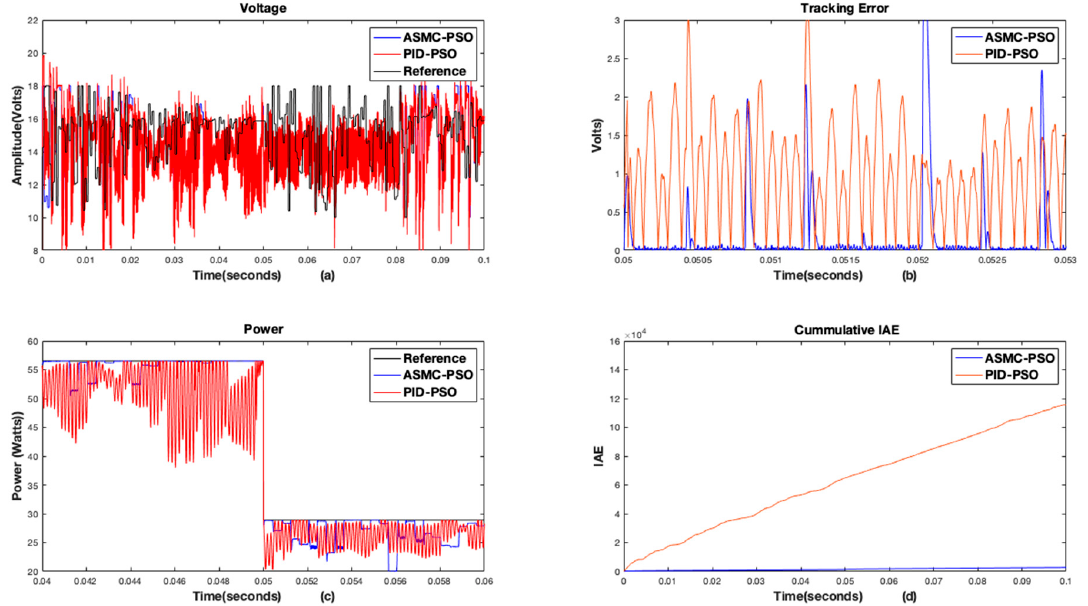
Figure 9. PID & ASMC based in PSO MPPT with 40 particles ( a ) Profile of the PV panel voltage. ( b ) Tracking response ( c ) Profile of the PV power extraction ( d ) IAE. Table 4. Performance characteristics of the conventional controller and the proposed ASMC controller based on PSO 10 particles.